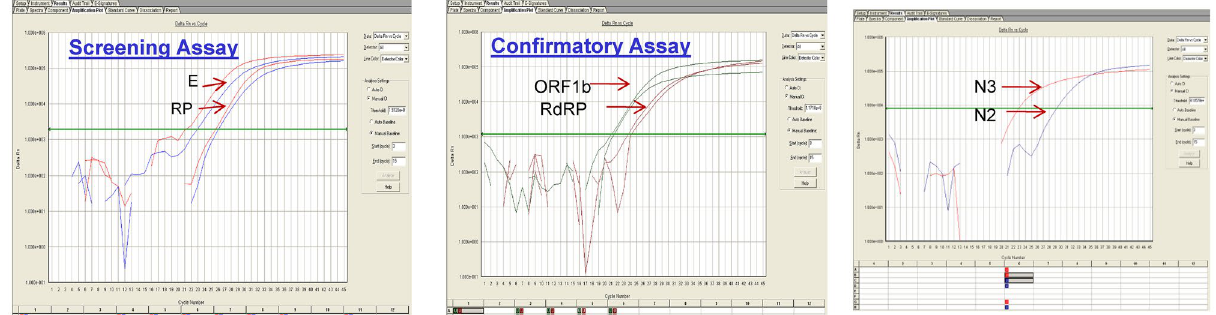
Figure 1. Representative amplification plot of SARS-CoV-2 positive samples showing amplification curve against different gene targets (E/RnaseP, Orf1b/RdRp, N